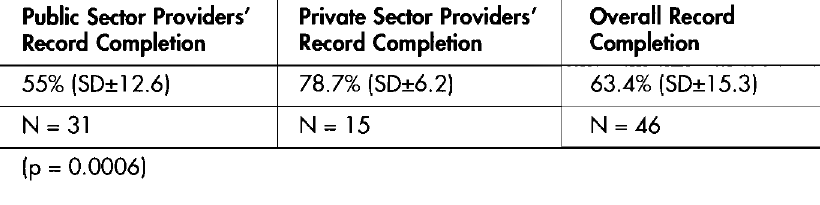
Table 3b: Record Completion for Sample Expressed as One Mean for Each Provider.